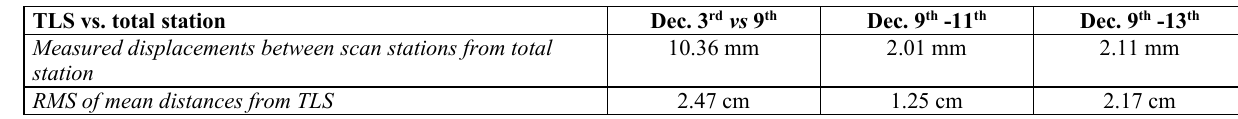
Table 6. RMSs of the distances between representative points in corresponding blocks obtained from tls data analysis and displacements of the scan station obtained from total station